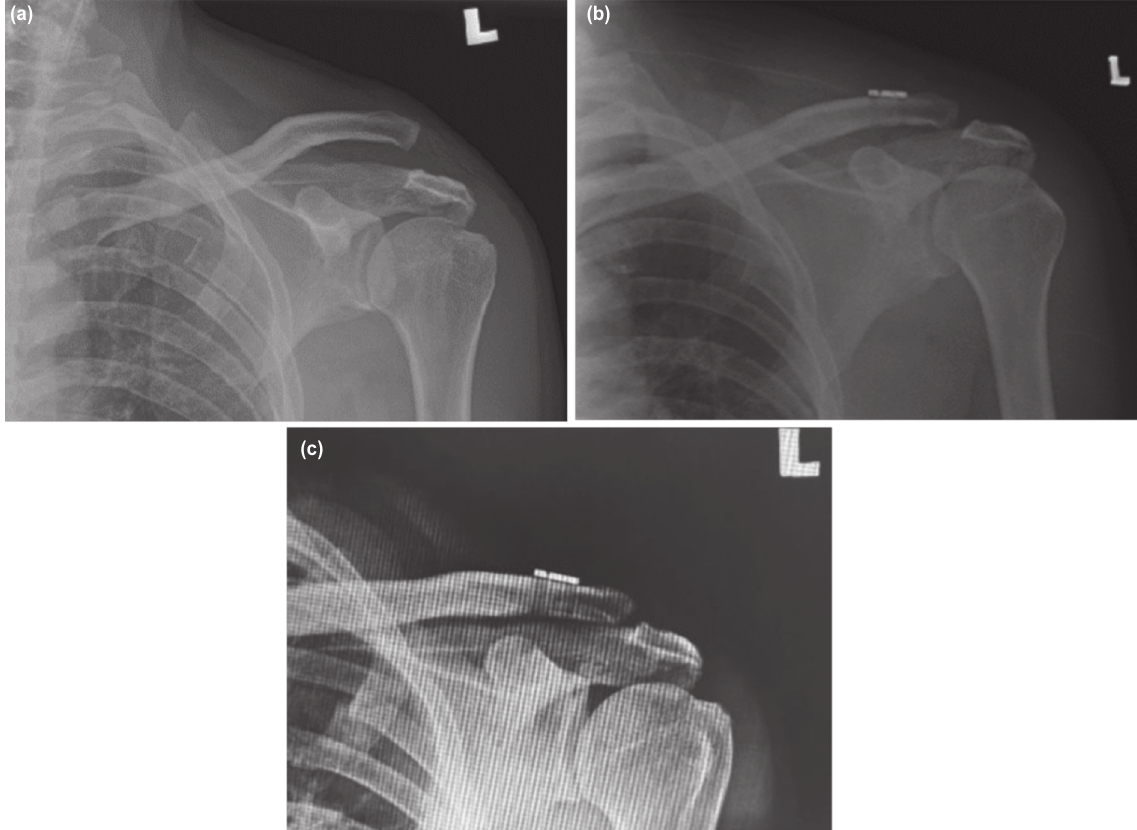
(a) Preoperative anteroposterior radiograph of left shoulder showing Rockwood’s grade V AC joint dislocation. (b) Immediate Fig. 1: postoperative radiograph showing left AC joint reduced. (c) At 6 week follow-up, left AC joint reduction was maintained, no graft or hardware failure noted.